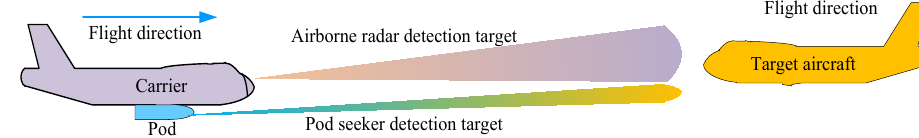
Figure 1. Composition of the “target situational awareness” test system.